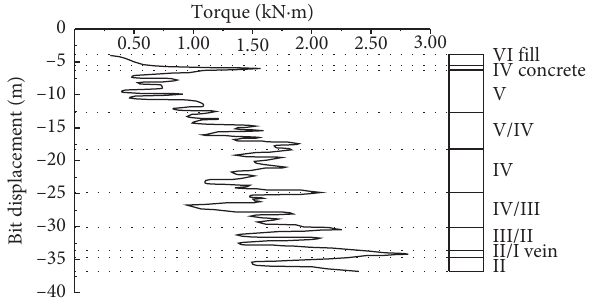
Figure 4: Rotation speed change graph.